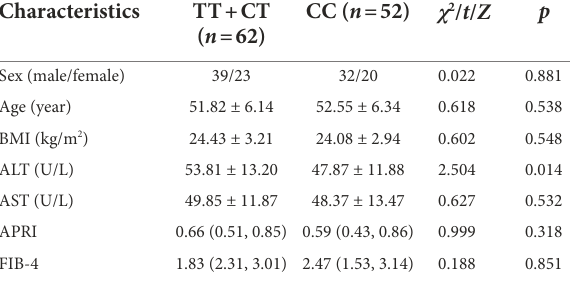
TABLE 5 Comparison of rs6692977 genotypes with demographic and clinical characteristics. Characteristics